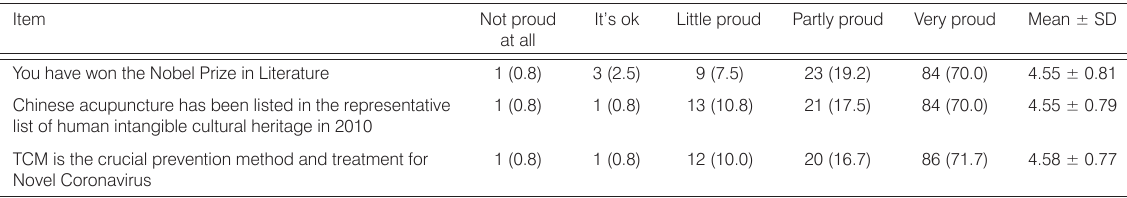
Table 4. Feelings about TCM achievements ( n ,